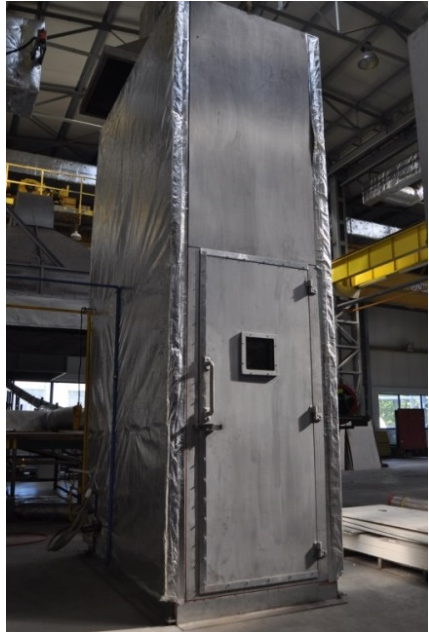
Figure 1. External view of EN 50399 standard test chamber at the accredited ITB Fire Testing Laboratory in Pionki, Poland.